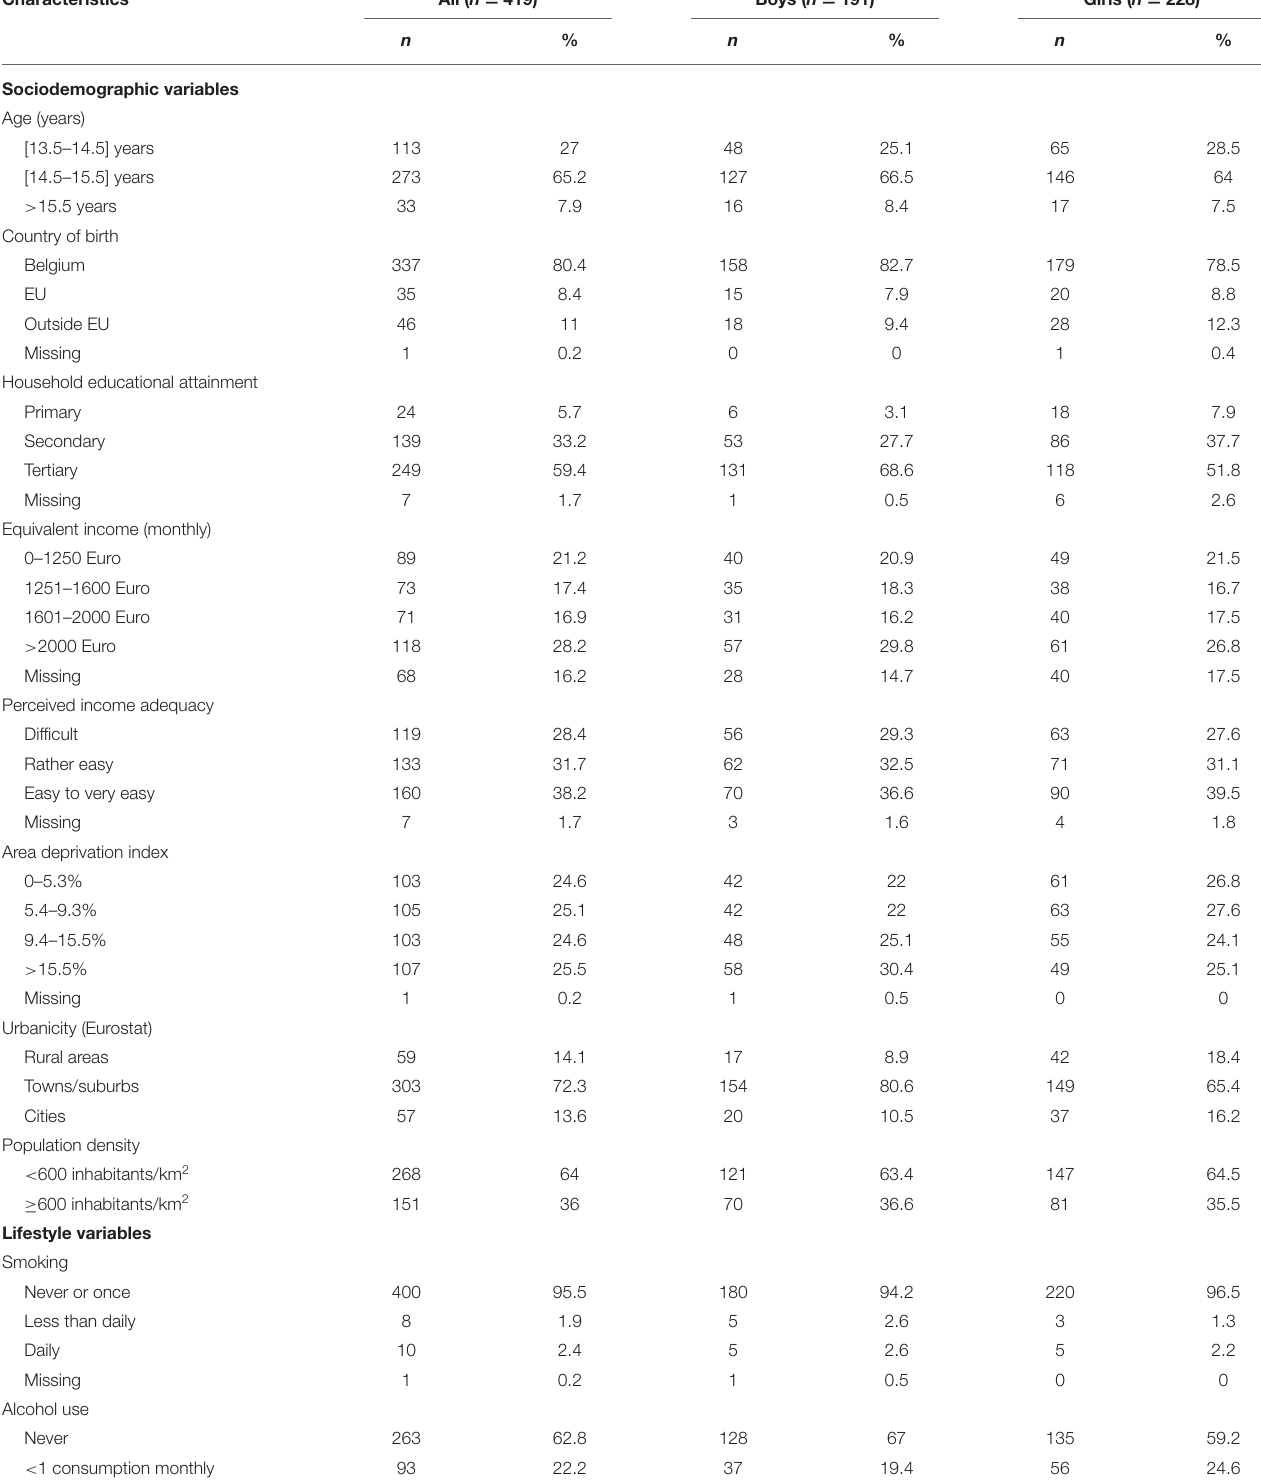
TABLE 1 | Study population characteristics.